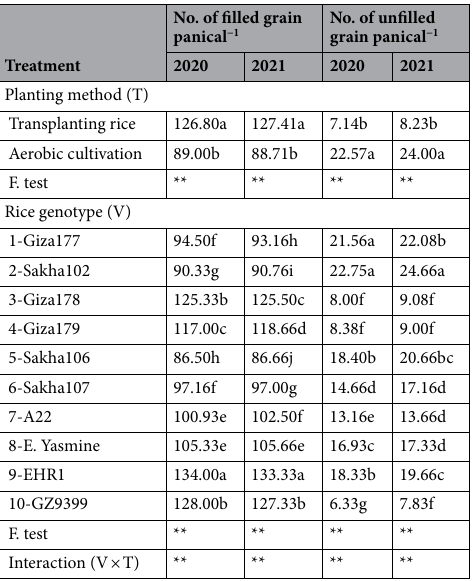
Table 13. Filled grains and unfilled grains/panicle numbers of some rice affected by the planting methods. **Significant at 0.01 level. Means followed by a common letter at the same column are not significantly different according to Duncan ’ s multiple range at 0.05 levels.